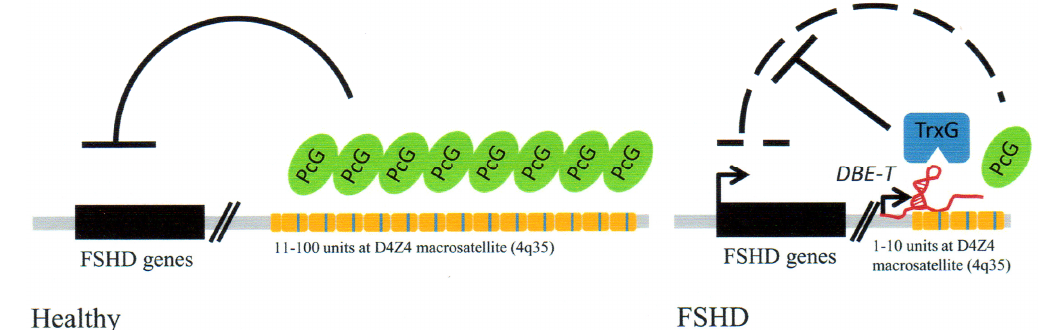
Figure 4. Involvement of repeat units (in orange) and lncRNA (in red) in FSHD muscular dystrophy. DBE-T, lncRNA; TRG, Trithorax proteins; other terms are defined in text . From Casa and Gabellini [17]. Reprinted with permission of